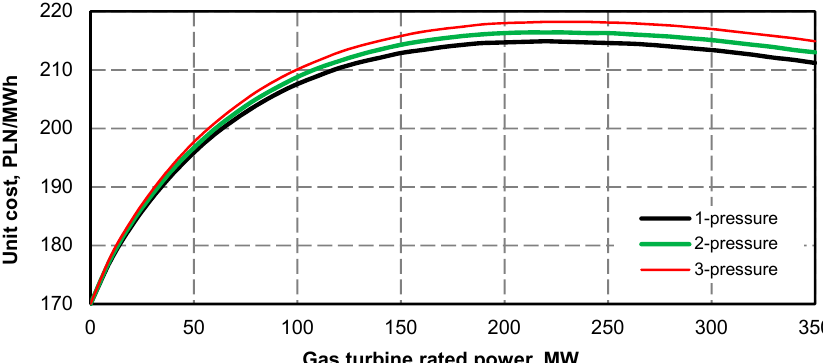
Figure 41 . Unit generation cost for electric power as a function of gas turbine rated power for various structures of a recovery boiler ( e c = 10.0 PLN/GJ, e g = 27.7 PLN/MWh, ( k el ) ex = 170 PLN/MWh).